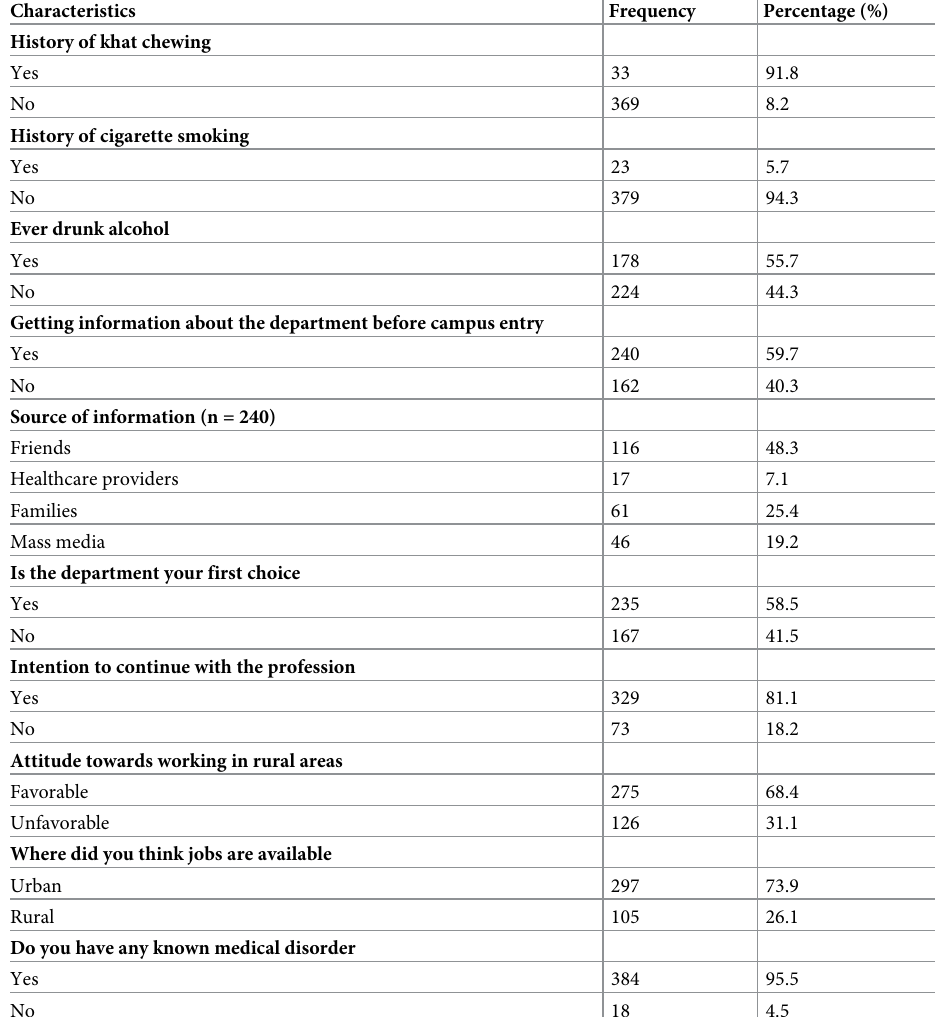
Table 2. Academic, medical, and behavioral related characteristics of study participants in the University of Gon- dar, college of medicine and health sciences, northwest Ethiopia, 2021 (n = 402).